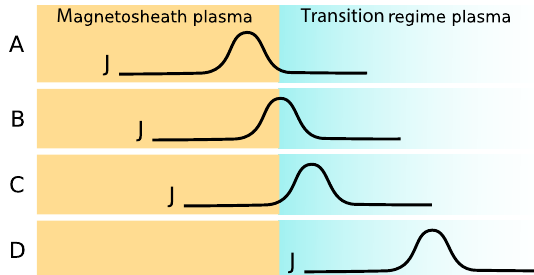
Figure 12. Schematic representation of the categorization of the current locations with respect to the ambient plasma regimes. The outermost edge, where changes in the plasma can be observed, is represented by the changing background colour. The four cases show currents that lie in front of (A), across (B), shortly behind (C) and clearly detached from (D) this edge.